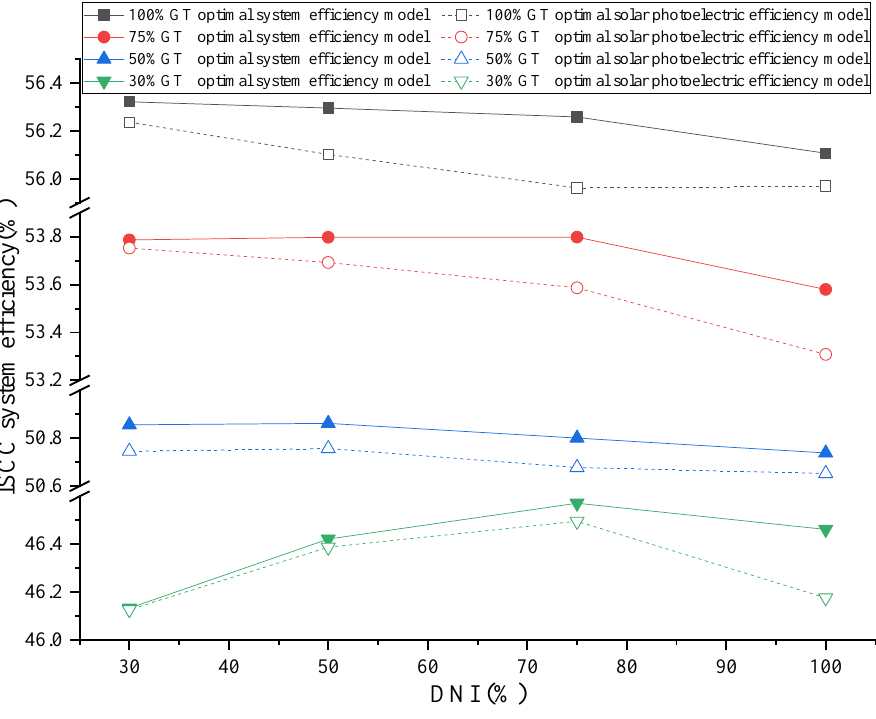
Figure 10. Trend of system efficiency with fluctuation of